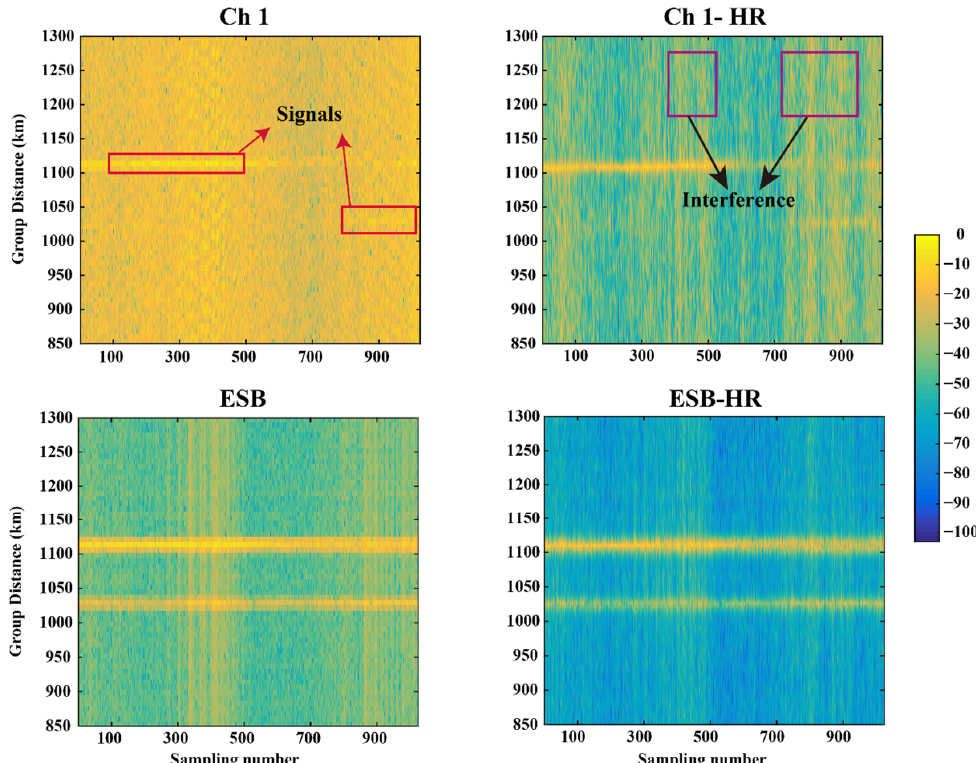
Figure 10. The OIS ionogram of 7.6 MHz under different conditions.